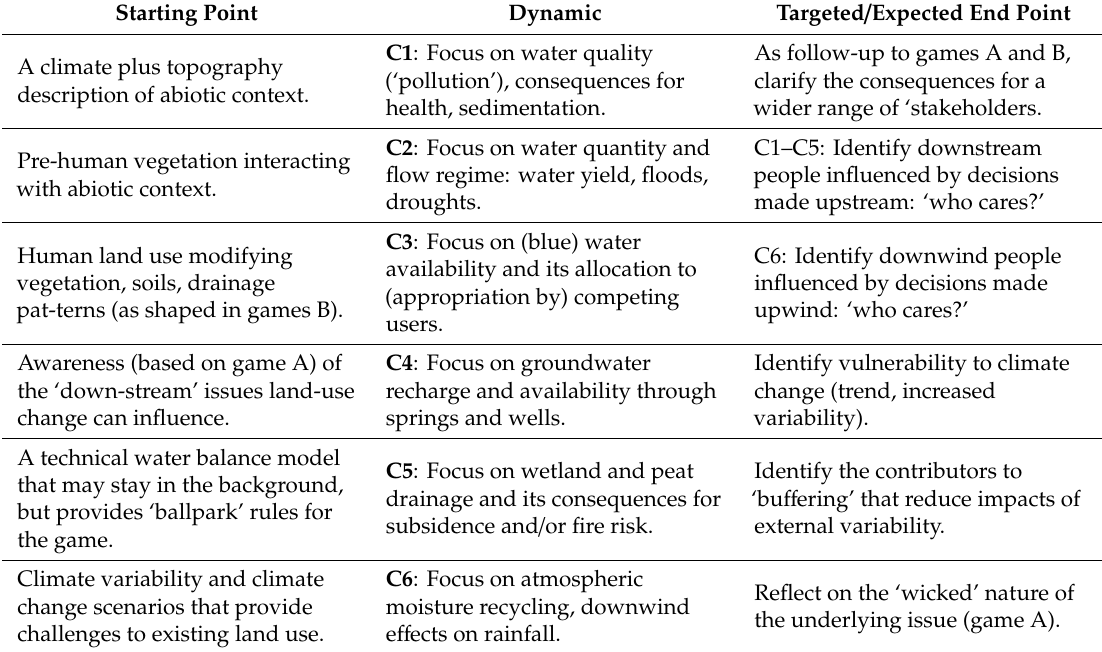
Table 6. Prototype of a so what? who cares? game with eco-hydrological consequences, with targeted / expected endpoints as hypothesis for further corroboration; type C in Figure 10. Starting